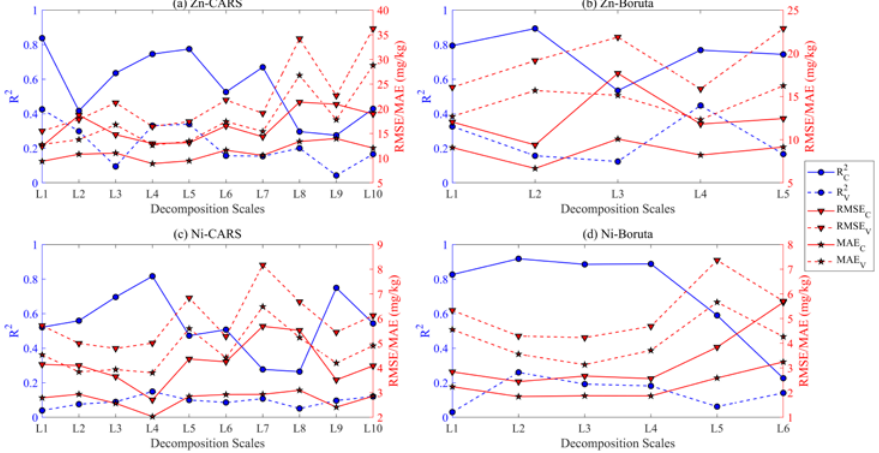
Figure 7. Evaluating RF model performance at each decomposition scale of CWT. For the Ni element, the best RF prediction model with the highest R 2 (0.2615),